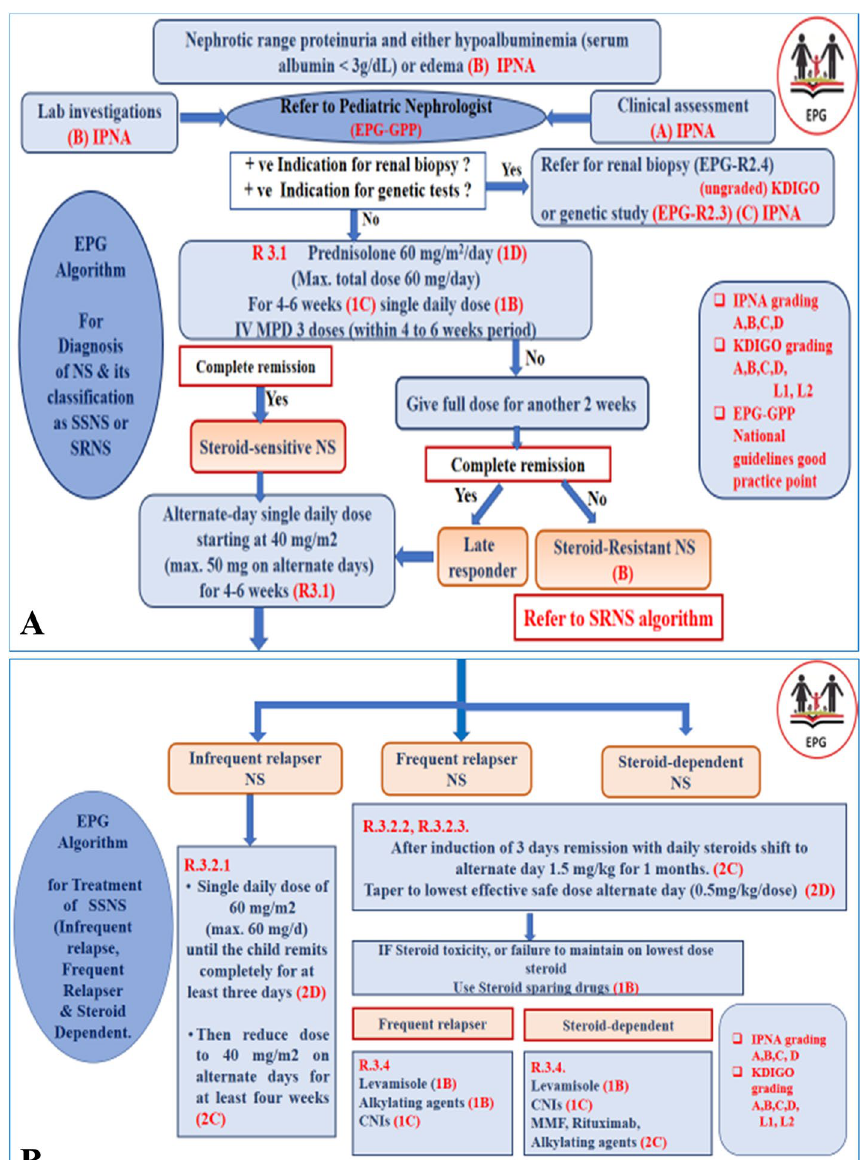
Fig. 2 A EPG algorithm for diagnosis of NS and its classification as SSNS or SRNS. B EPG algorithm for treatment of SSNS (infrequent relapse, frequent relapser, and steroid